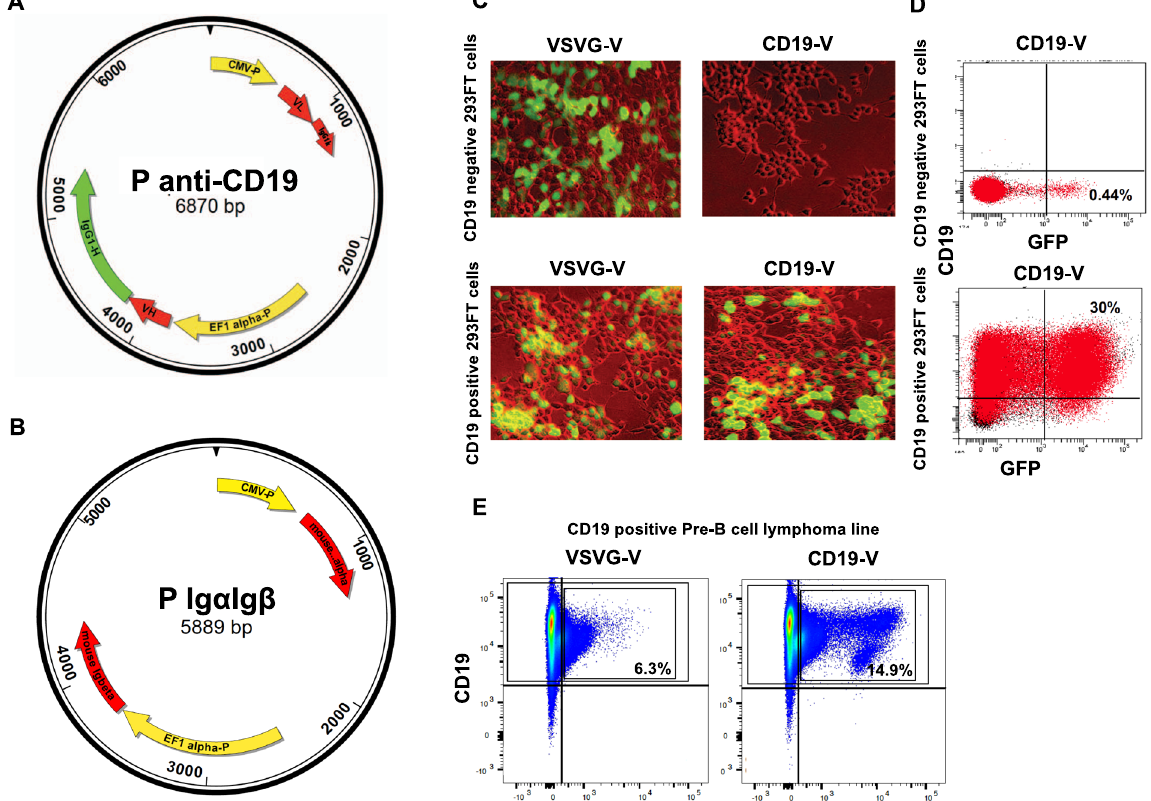
Figure 1. Lentiviral vectors pseudotyped with anti-CD19 antibodies efficiently target CD19-positive cells. ( A ) p α mCD19 plasmid map. The light chain and heavy chain variable regions of monoclonal rat anti-mouse CD19 were obtained by PCR from the clone 1D3 (ATCC). To generate p α mCD19, the full-length chimeric light chain and full-length heavy chain regions were cloned into pBudCE4.1 (Invitrogen) under control of the CMV promoter and the EF1 α promoters, respectively. ( B ) pmIg αβ plasmid map. Genes encoding mouse Ig α and Ig β , proteins required for expression of antibodies on the surface of cells, were amplified by RT-PCR and inserted into pBudCE4.1, designated pmIg αβ . ( C – E ) Lentiviral transduction of CD19 − , CD19 + 293-FT cells or of 18.81 CD19 + Pre-B cells with anti-CD19 (CD19-V) or VSVG (VSVG-V) pseudotyped lentiviruses. Transduced cells can be identified by expression of GFP (green, C, or on the x-axis D and E). The figure shows that anti-CD19 pseudotyped viruses specifically transduce CD19 + cells, while control virus transduces (transduce intead of transduces) CD19 − and CD19 + cells. ( D ) Shows flow cytometry analysis of CD19 − and CD19 + 293FT cells transduced with anti-CD19 pseudotyped lentiviruses. Anti-CD19 pseudo-viruses transduce 293FT CD19 + cells > 68 times more efficiently than 293FT CD19-negative cells. ( E ) Shows that CD19-V transduce Pre-B lymphoma cells expressing endogenous CD19, 2.4 more efficiently than VSVG-V at 72 hours